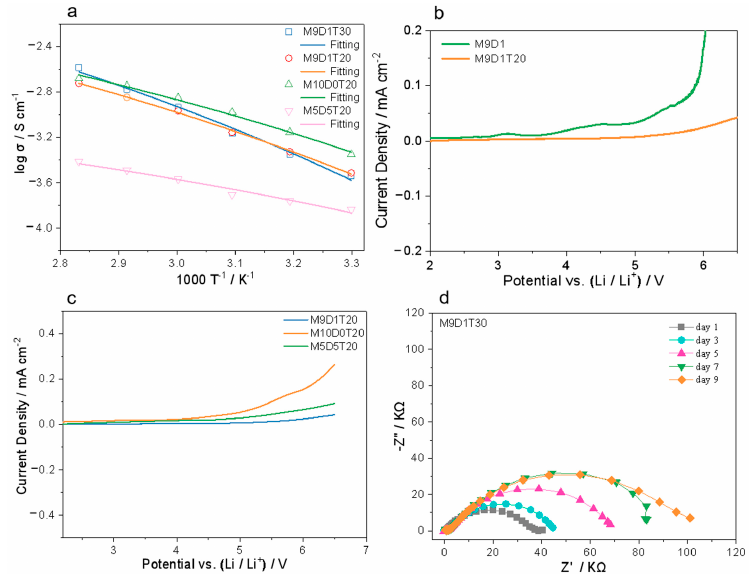
Figure 3. ( a ) Temperature dependencies of the ion conductivities of PEs. LSV curves ( b , c ) using double-network PEs with different ratios of TEOS and zwitterions. ( d ) EIS of Li/Li cell using M9D1T30.